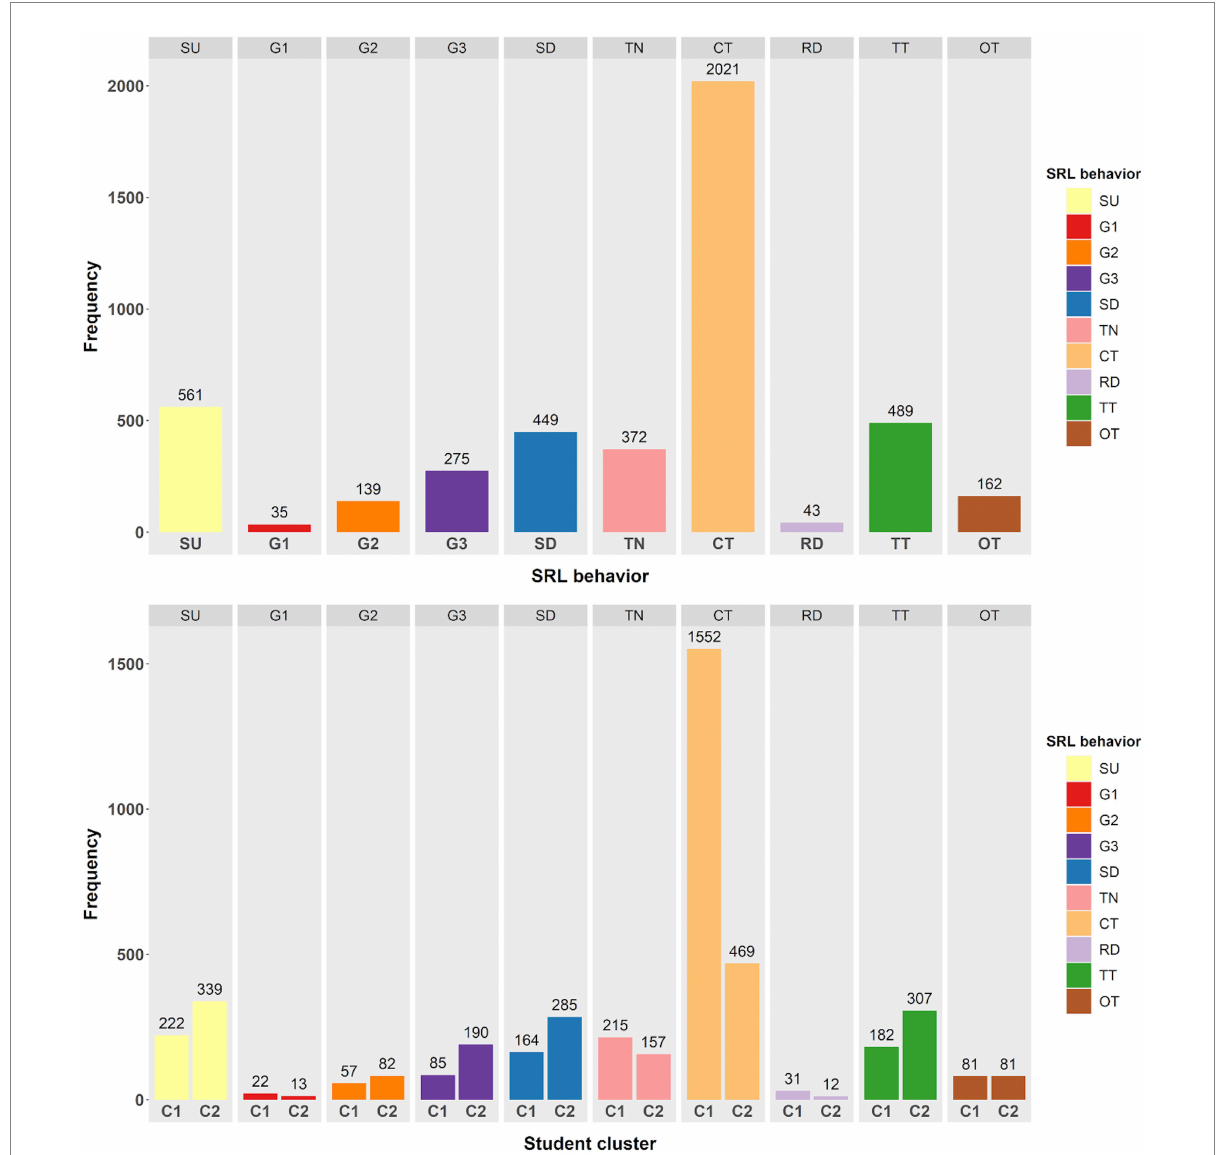
FIGURE 5 The frequencies of SRL behaviors for the overall sample (top) and the two clusters (bottom). C1 = Cluster 1; C2 = Cluster